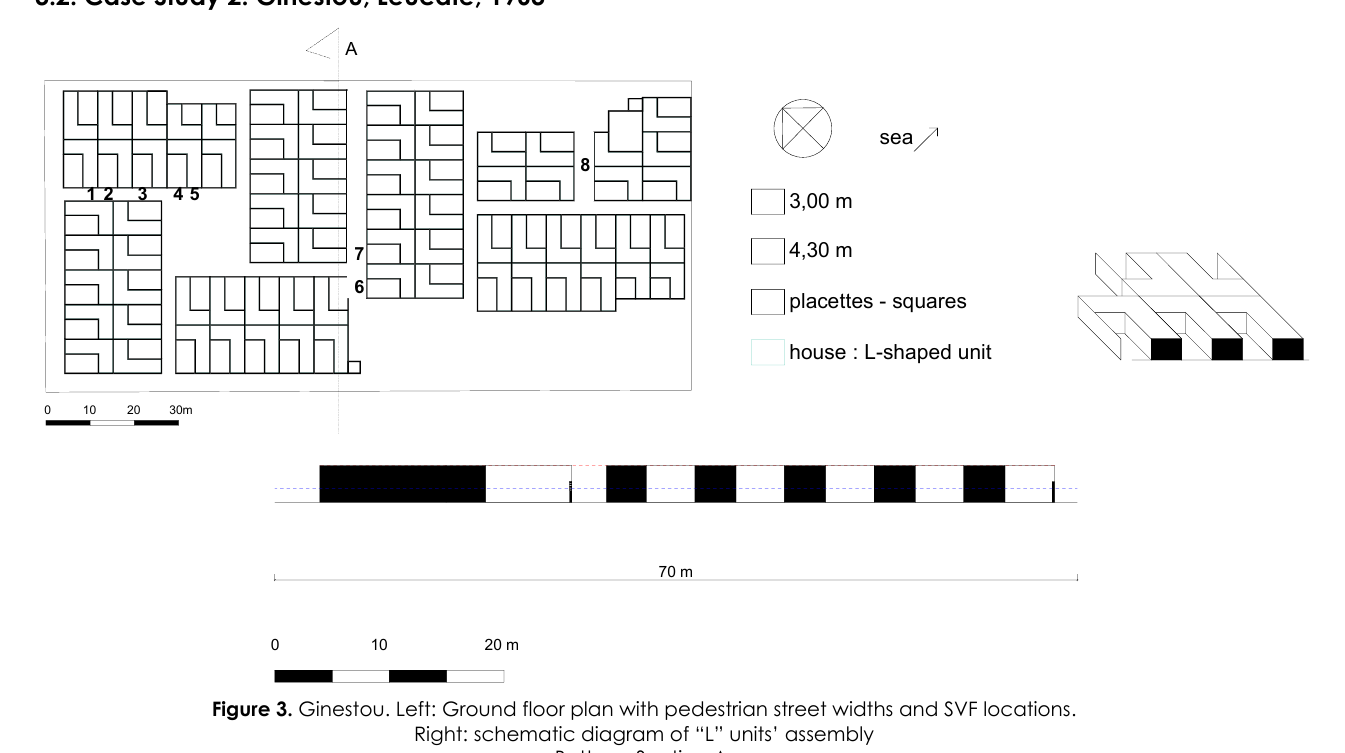
Figure 3. Ginestou. Left: Ground floor plan with pedestrian street widths and SVF locations. Right: schematic diagram of “L” units’ assembly Bottom: Section A. Red line: mean building height; Blue line: Absolute Rugosity or mean urban canopy